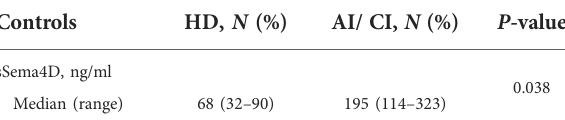
TABLE 1 Demographics and clinical information of the HNSCC samples, HD, and AI/CI